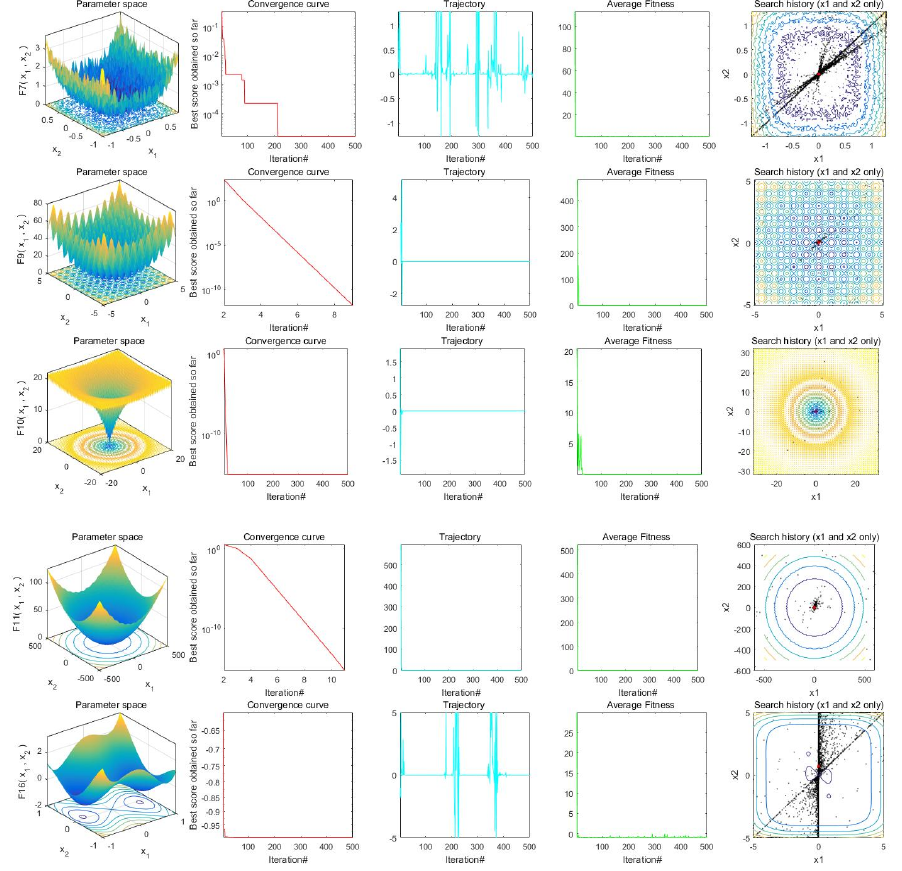
Figure 7. The convergence curve, the trajectories, the average fitness history, and the search history of certain functions.